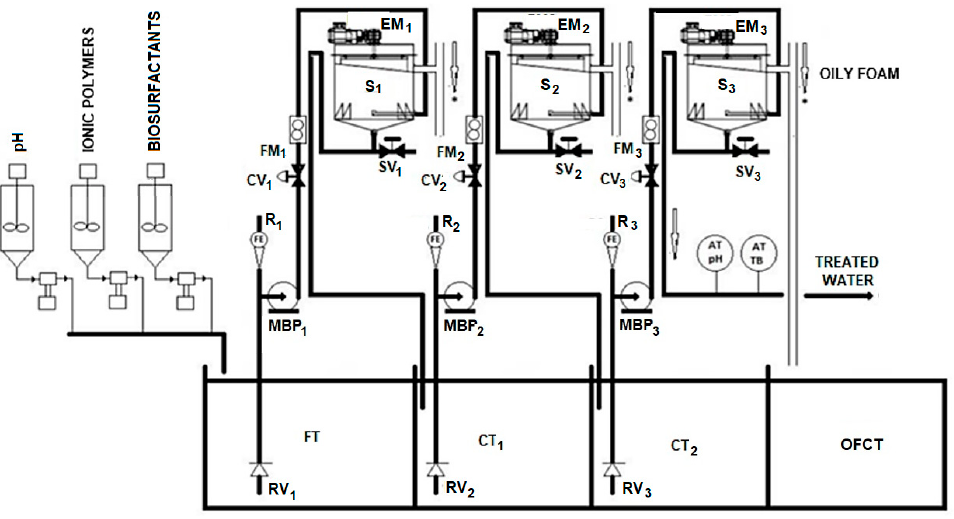
Figure 1. Schematic diagram of the main components of the semi-industrial IPST.